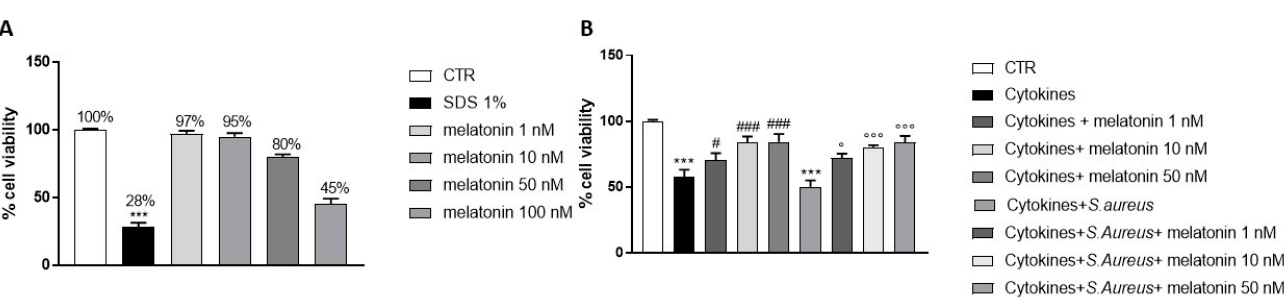
Figure 1. Effect of melatonin on RHE cell viability. MTT assay revealed that melatonin treatment 1, 10, and 50 nM did not exert any cytotoxic effects on RHE cell viability, but the treatment at 100 nM reduced cell viability by 45% ( A ). Additionally, the panel B revealed that RHE cell viability was reduced following cytokines and S. aureus treatment; however, melatonin 1, 10, and 50 nM restored cell viability. Data are representative of at least three independent experiments. ( A ) *** p < 0.001 vs. CTR. ( B ) *** p < 0.001 vs. CTR; # p <0.05 vs. cytokines group; ### p < 0.001 vs. cytokines group. ° p < 0.05 vs. cytokines + S. aureus group; °°° p < 0.001 vs. cytokines group + S. aureus group .